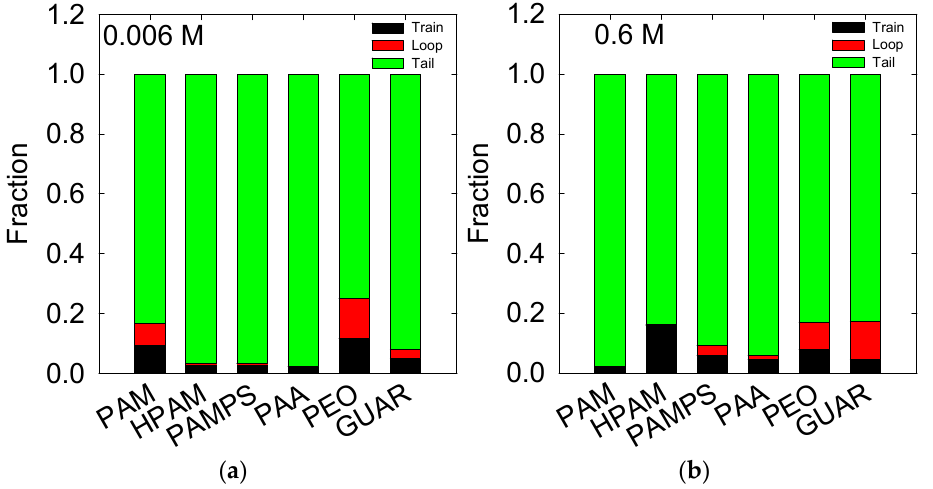
Figure 6. Time average of the train, tail, and loop fractions at salt concentrations of ( a ) 0.006 M and ( b ) 0.6 M of NaCl.